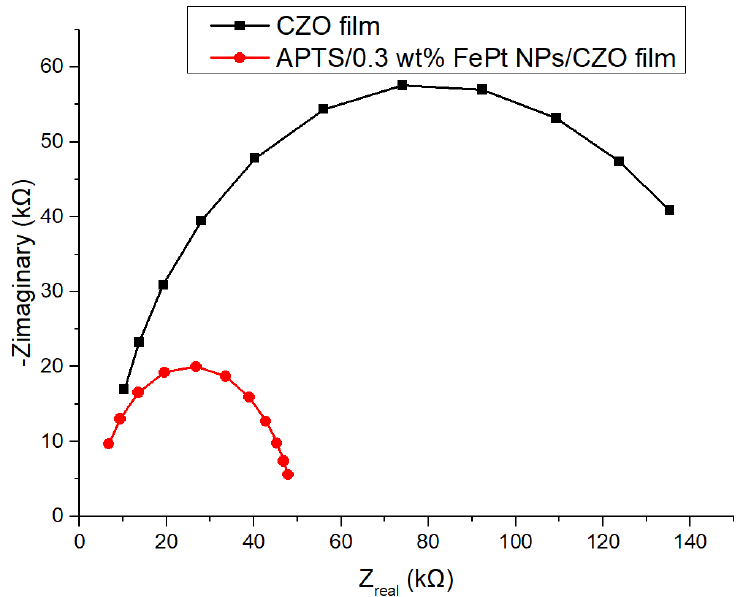
Figure 11. The curves of EIS analysis for flexible lactate biosensor based on FePt NPs/CZO sensing films, and equivalent circuit (inset).